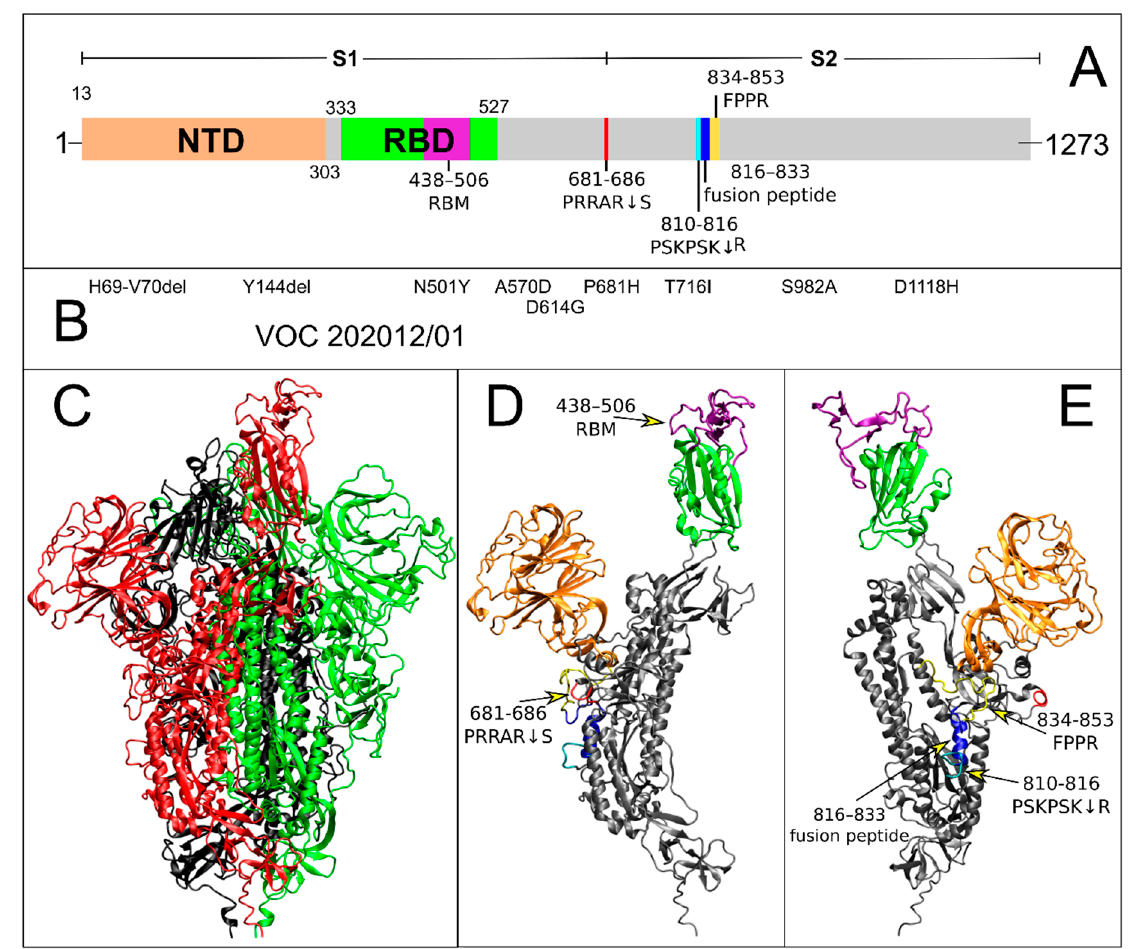
Figure 1. Domain organization and UK variant sequences in the S protein. ( A ) The S protein is divided in two regions, S1 and S2. In S1, the NTD and RBD are colored in orange and green, respectively. Within the RBD, the RBM is highlighted in purple. The newly acquired furin-like cleavage site at the S1/S2 boundary is highlighted in red. The two neighboring second cleavage site [35] and fusion peptide regions are highlighted in cyan and blue, respectively. ( B ) The VOC 202012/01 mutations are mapped along the S protein sequence. ( C ) Cartoon representation of the WT snapshot after 629.8 ns of MD simulation, centroid of the most populated protein cluster. The three monomers are colored in black, red, and green, respectively. Monomer 2 is the one in up conformation. ( D , E ) Monomer 2 of the same MD snapshot in two different orientations. S protein key regions are colored and highlighted as in panel A.